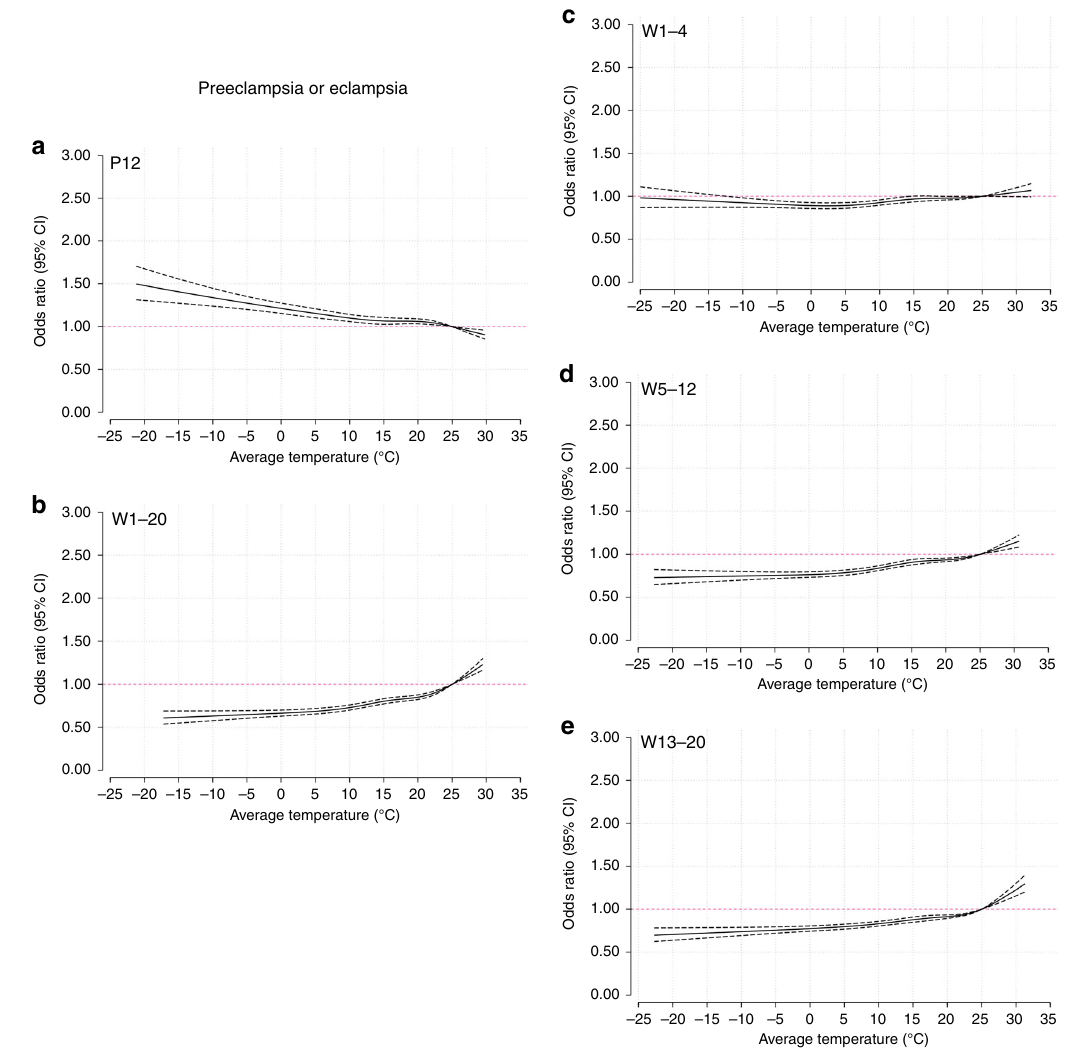
Fig. 2 Curves of the associations between average temperatures and preeclampsia or eclampsia. Solid black lines correspond to points estimate of aORs of preeclampsia or eclampsia; dashed black lines correspond to 95% con fi dence intervals. a 12 weeks preconception; b 1 – 20 weeks postconception; c 1 – 4 weeks postconception; d 5 – 12 weeks postconception; e 13 – 20 weeks postconception. P preconception, W weeks postconception. Source data are provided as a Source Data fi